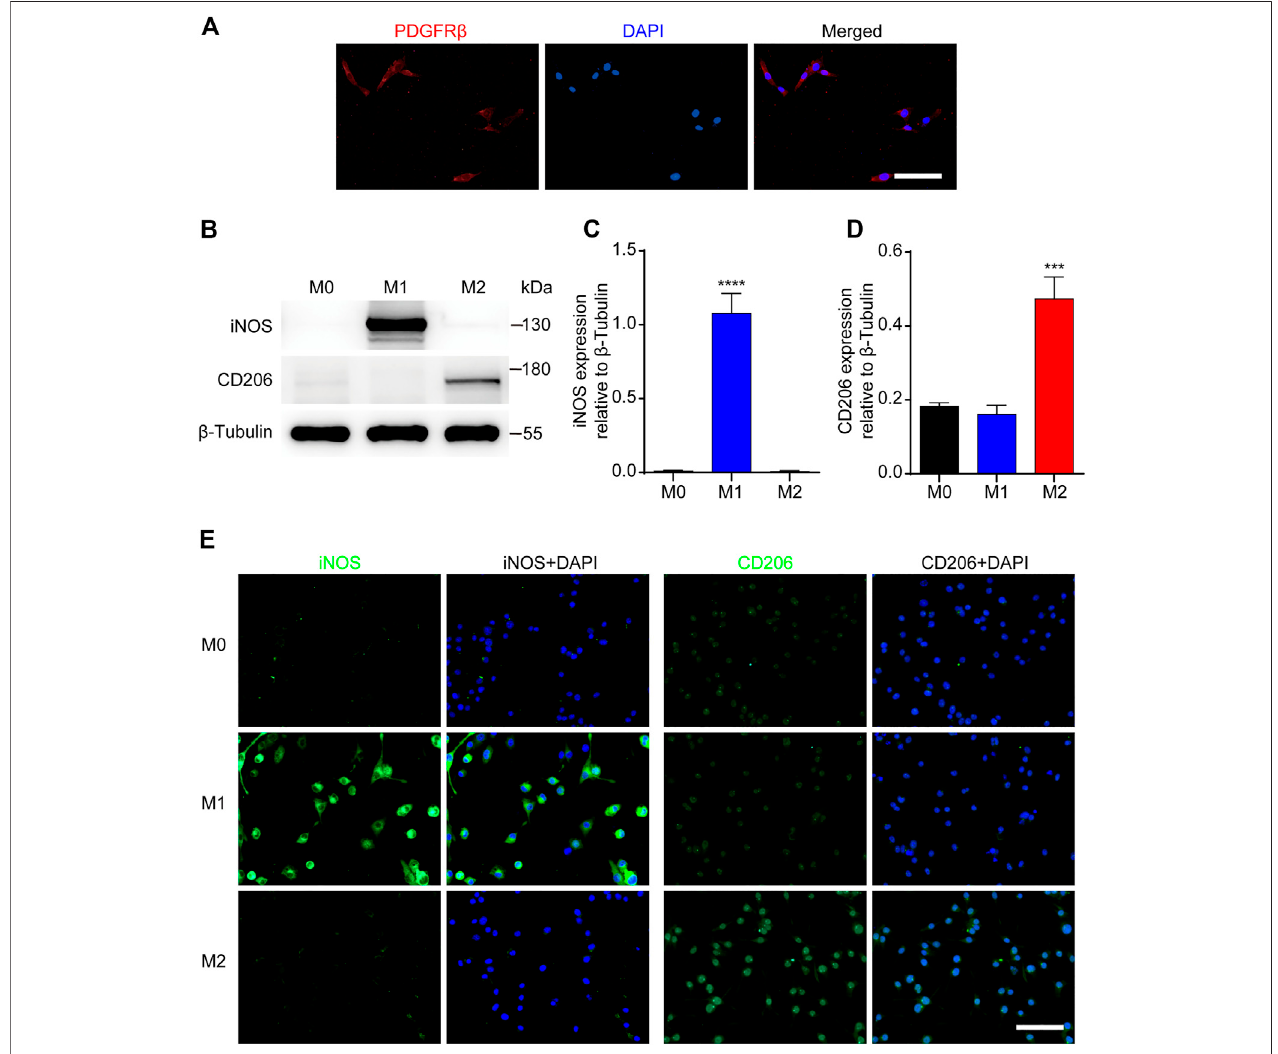
FIGURE 3 | Identi fi cation of PDGFR β + pericytes and polarized macrophages in vitro . (A) Immunocytochemistry staining was used to detect PDGFR β + (green) and DAPI-stained nuclei(blue)inMBVPcells. (B) Western blotwasused todetect theexpression levels ofM1(iNOS) orM2(CD206) polarizationmarkers inRAW264.7 cells after polarizationtreatment. (C,D) QuantitativeanalysisofiNOSandCD206expression. Theblots( n (cid:2) 5pergroup) werequanti fi edbyadensitometric methodusingthe ImageJ software. The results were expressed as mean ± SD. **** p < 0.0001 (CM1 vs. other groups) in (C) ; *** p < 0.001 (CM2 vs. other groups) in (D) . (E) Representative fl uorescence images of iNOS and CD206 in RAW 264.7 cells after polarization treatment, DAPI stained the nuclei. Scale bars, 50 μ m.